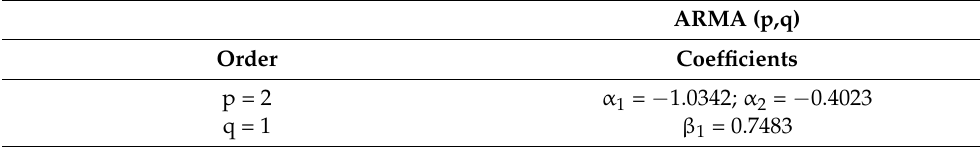
Table 10. Order and coefficients of ARMA (2,1).